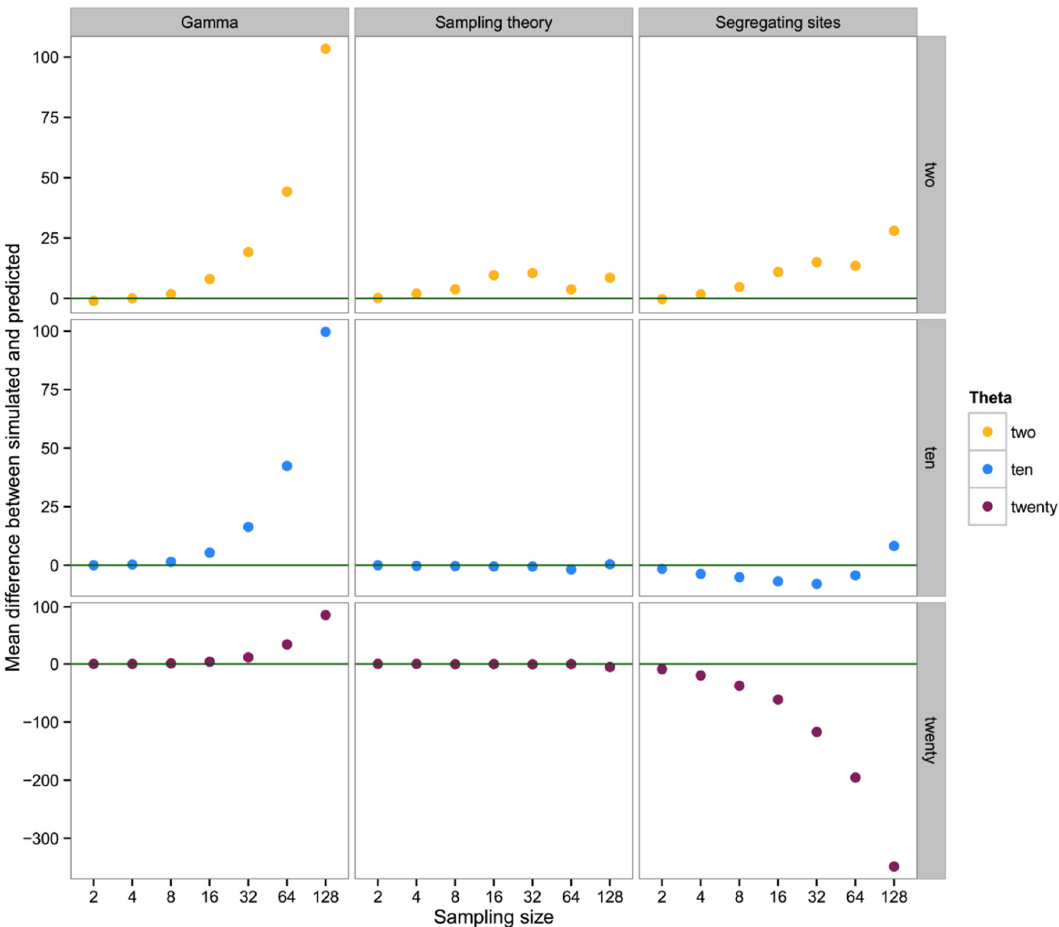
Figure 6. Mean difference between the simulated and the predicted sampling size for each combination of method (Ewens, Gamma, Wakeley) and θ (2, 10, 20). The zero line (in green) shows the ideal situation in which the estimation equals the simulated sampling size. Please note that the y-axis differ between θ panels.